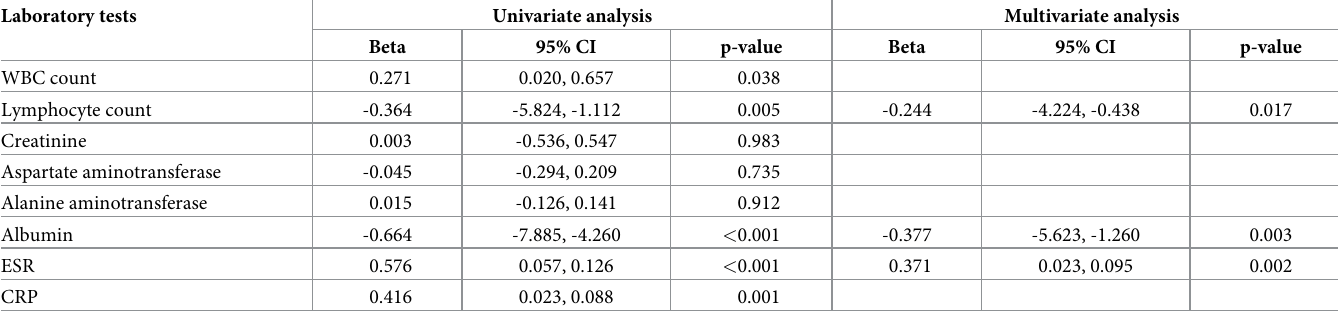
Table 4. Univariate and multivariate linear regression between laboratory tests and BVAS version 3 at baseline. Laboratory tests